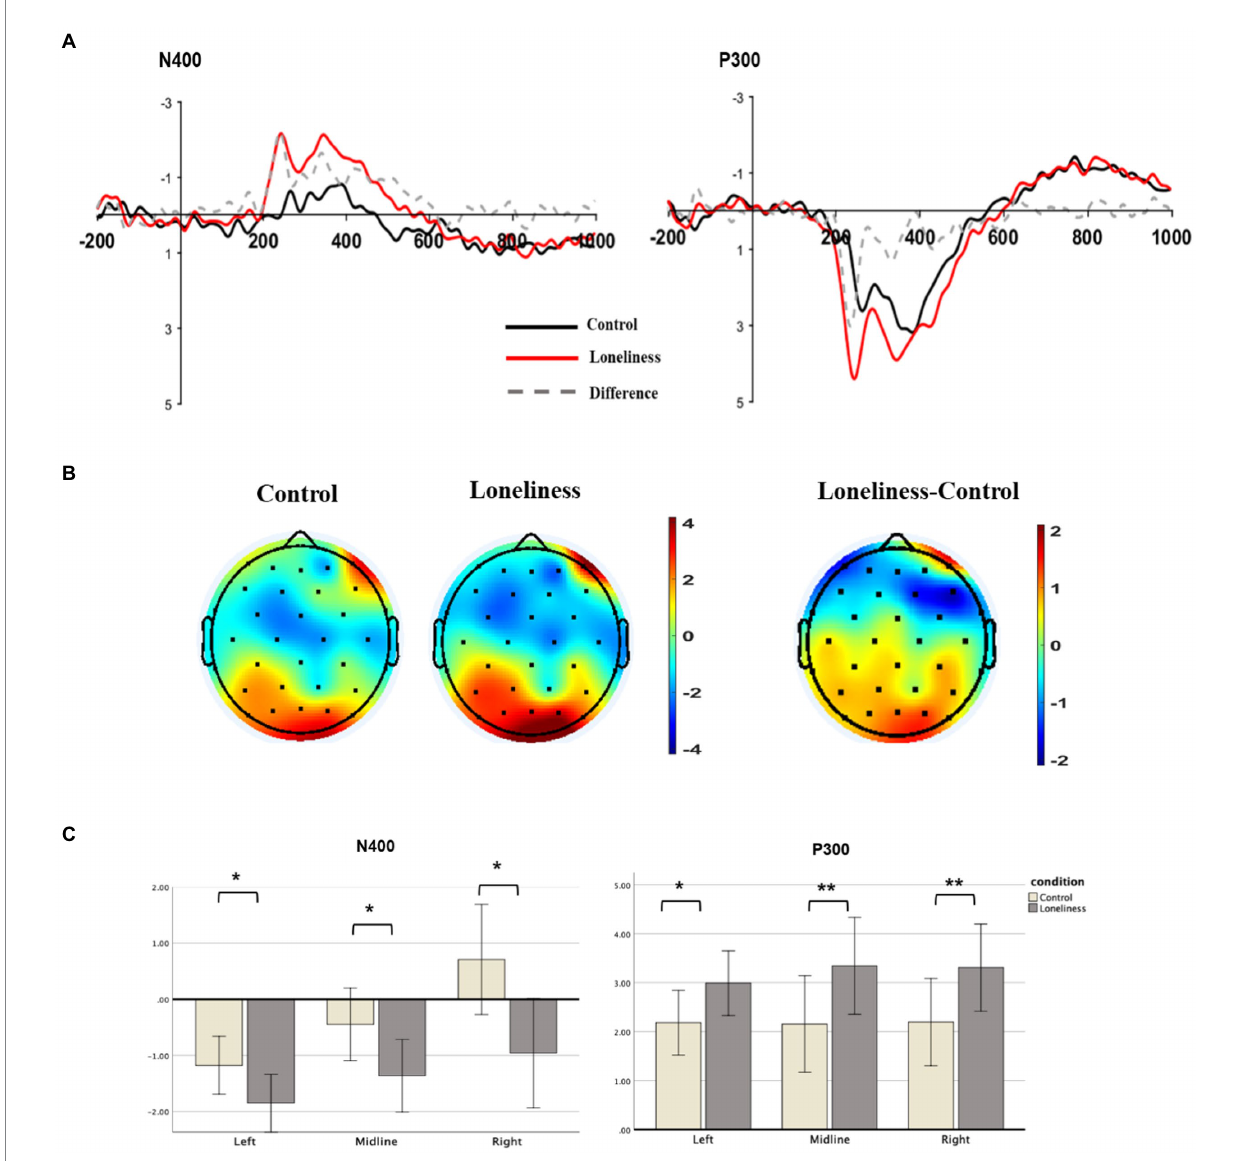
FIGURE 1 Grand mean ERP results for N400 and P300. (A) Grand averaged ERP waveforms on the frontal locations (F1, F2, F5, F6, AFz) and posterior locations (PO3, PO4, PO7, PO8, POz). (B) Topographical map for each condition and their difference at the time course from 200 to 500 ms. (C) Bar graph depicting mean N400 and P300 amplitudes at the frontal and posterior areas for control vs. loneliness priming conditions. The asterisk indicates a reliable difference between control vs. loneliness priming conditions. Error bars indicate standard